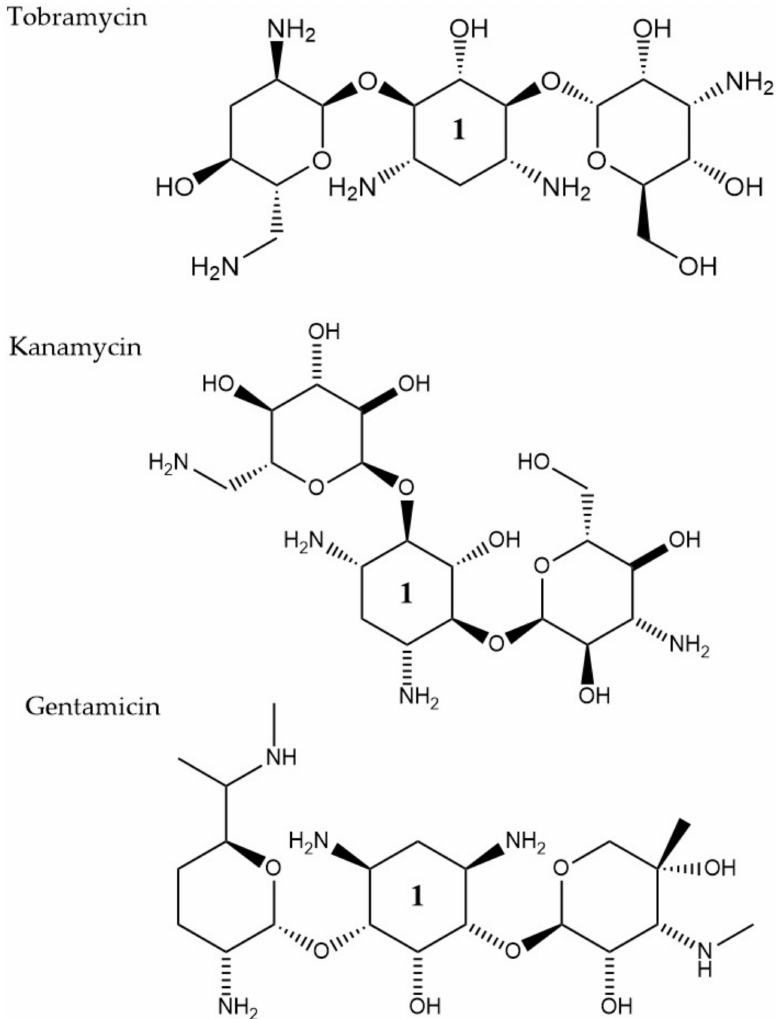
Figure 3. The chemical structures of three aminoglycoside compound. r tobramycin, kanamycin, and gentamicin are shown. All three compounds chare similar ring number 1 indicated across the